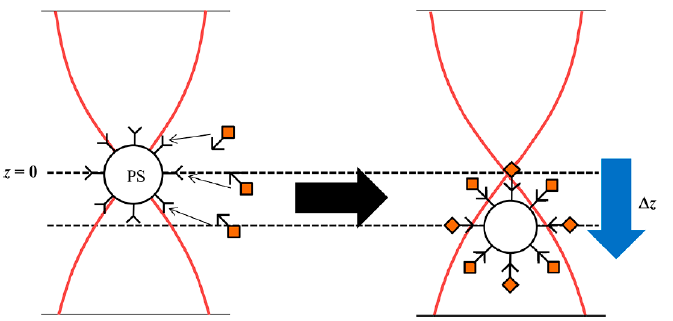
Figure 6. Schematic representation of the acoustic levitation for detection of the avidin–biotin reaction based on the density change. Reproduced from Ref. [74] with permission. Copyright 2018 American Chemical Society.